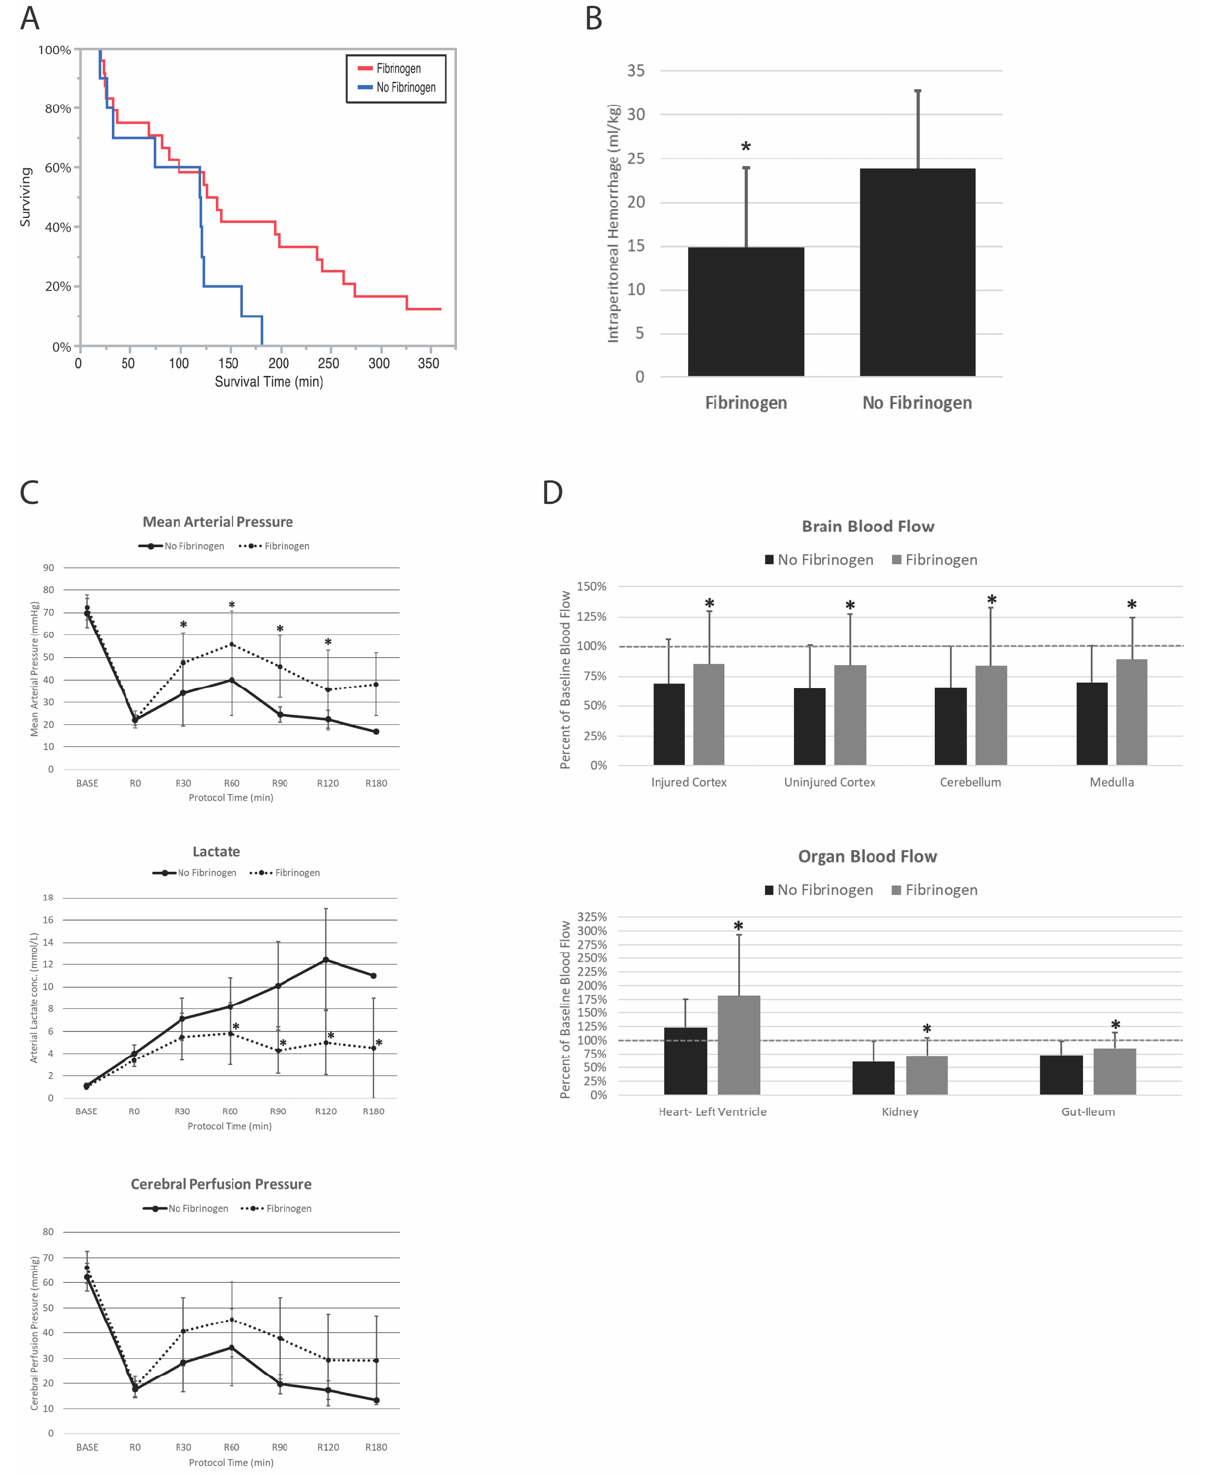
Figure 4. Combined effect of fibrinogen on survival time ( A ), intraperitoneal blood loss ( B ), hemodynamics and lactate ( C ), and vital organ blood flow ( D ). All animals received Hextend and vasopressin. Error bars represent standard deviation. * p < 0.05 compared to no fibrinogen with Tukey HSD adjustment for multiple comparisons.